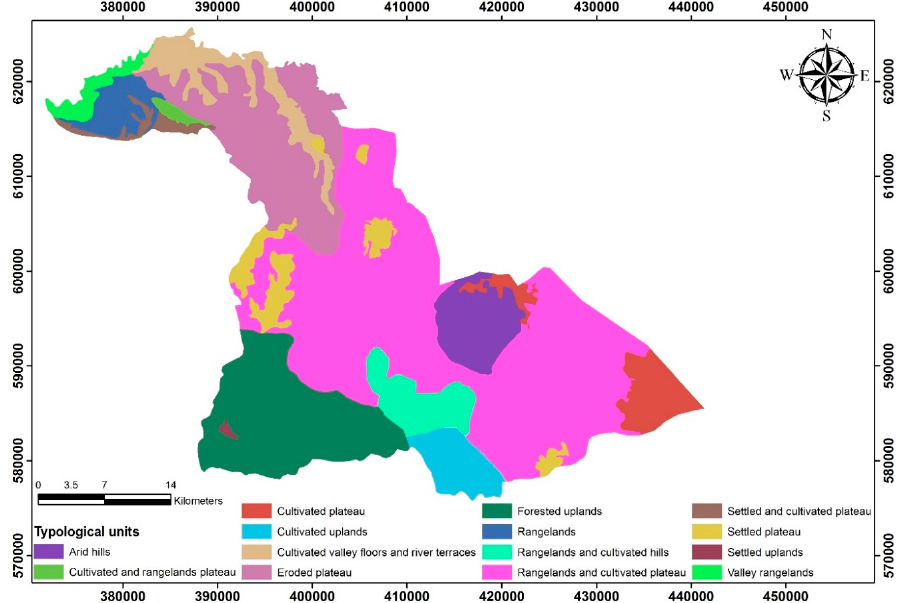
Figure 5. The 14 Typological units in the study area of Wadi Yarmouk. The numbers of units